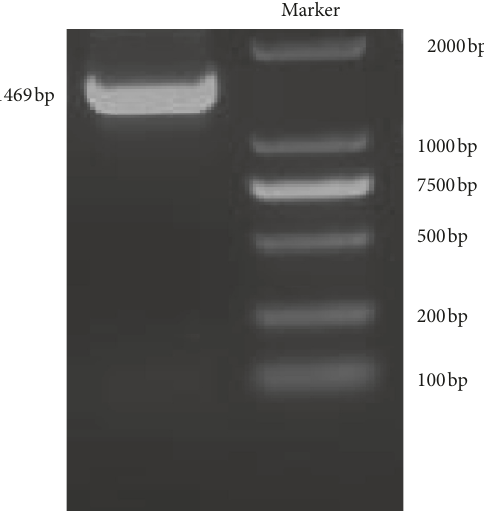
Figure 2: 16S rDNA amplification product